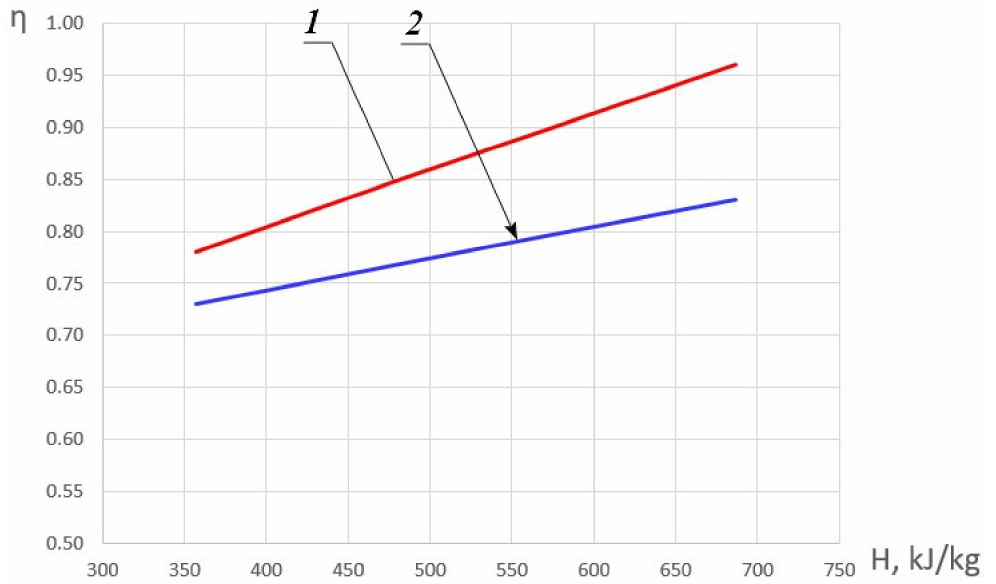
Figure 5. Dependence of the combustion completeness coefficient on the initial HOF enthalpy. 1— η max ; 2— η _ 1